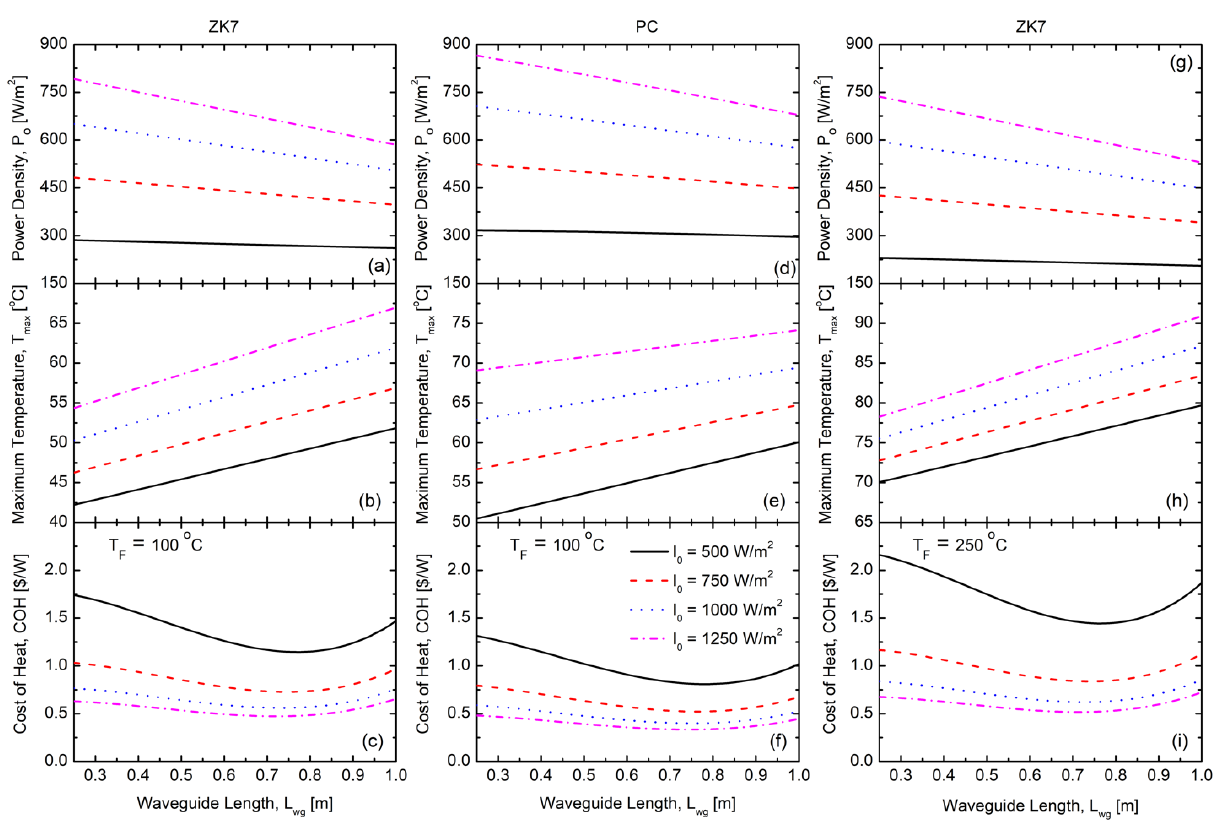
Figure 7. Variation of power density ( P o ), maximum waveguide temperature ( T max ) and cost of heat (COH) with waveguide length ( L wg ) at different I 0 for ( a – c ) ZK7 at T F =100 ◦ C, ( d – f ) PC at T F =100 ◦ C, ( g – i ) ZK7 at T F = 250 ◦ C. The receiver radius is 0.01 m and waveguide thickness is 0.02 m.